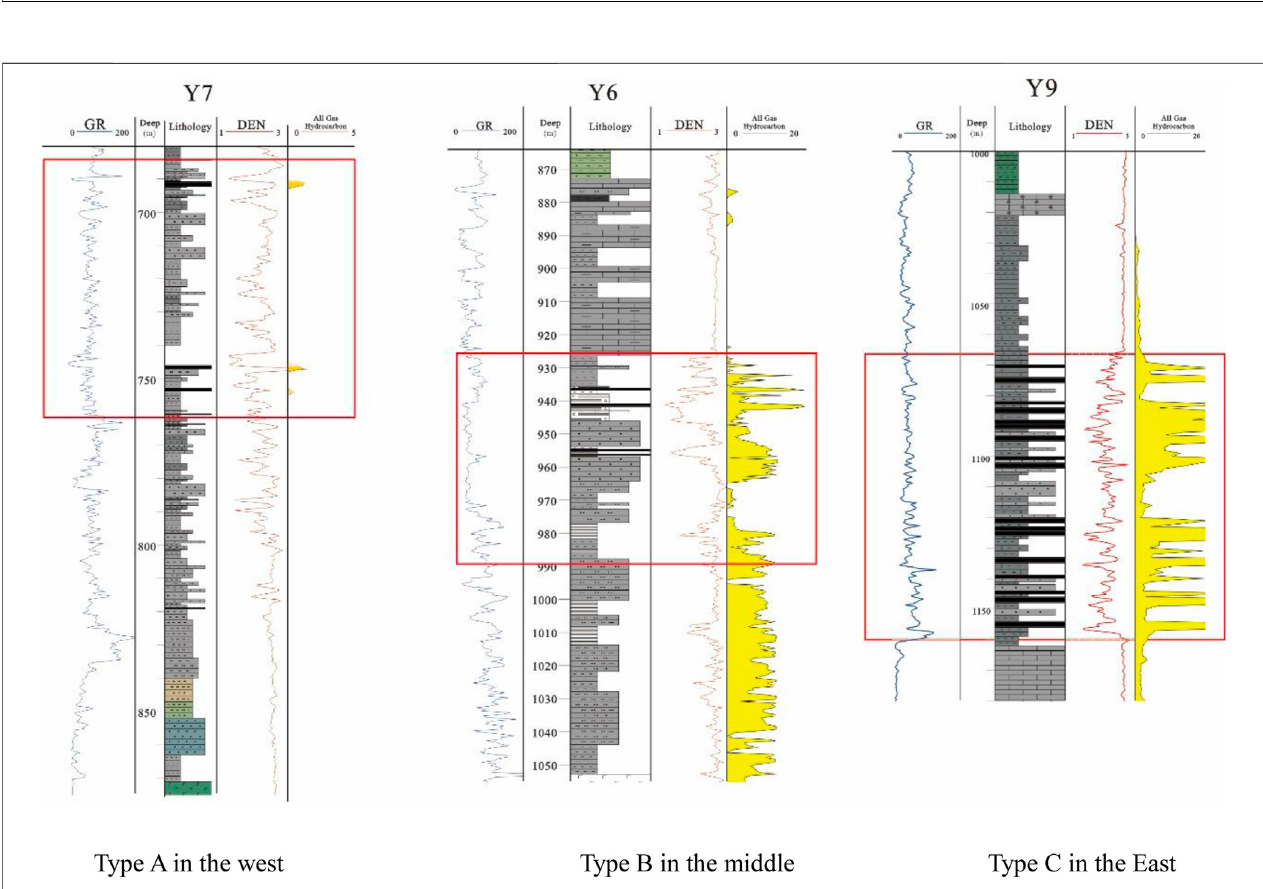
FIGURE 3 | Lithological association and distribution characteristics of the study area. The red box represents the Leping Formation. Type A in the west. Type B in the middle. Type C in the east.